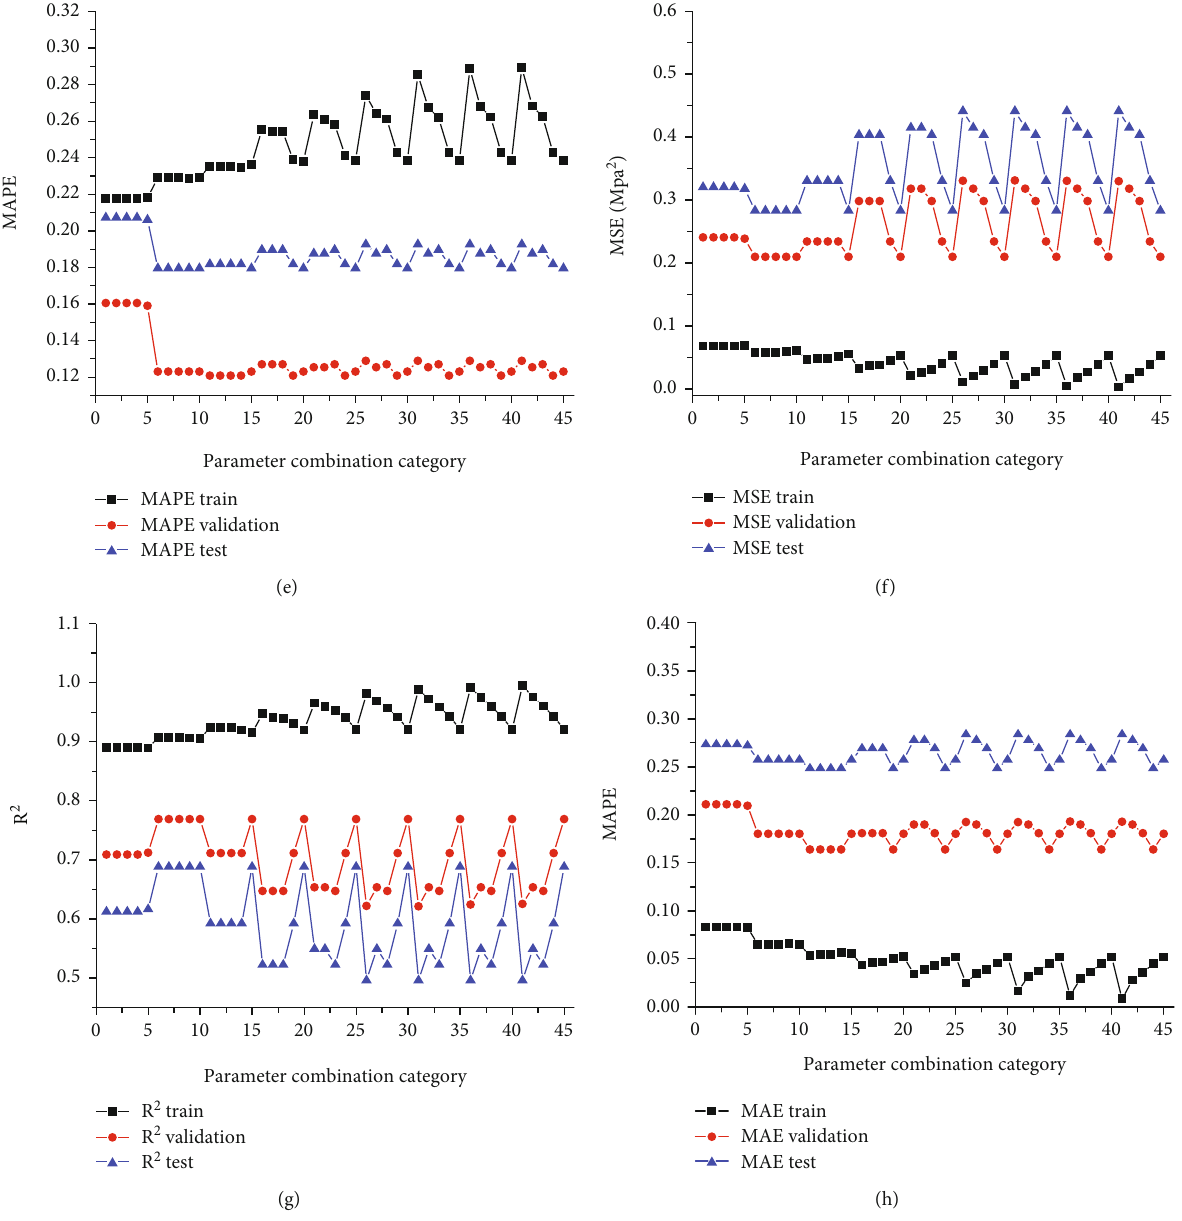
Figure 5: Results of di ff erent training methods. (a) Disordered training method MAPE value. (b) Disordered training method MSE value. (c) Disordered training method R 2 value. (d) Disordered training method MAE value. (e) Ordered training method MAPE value.